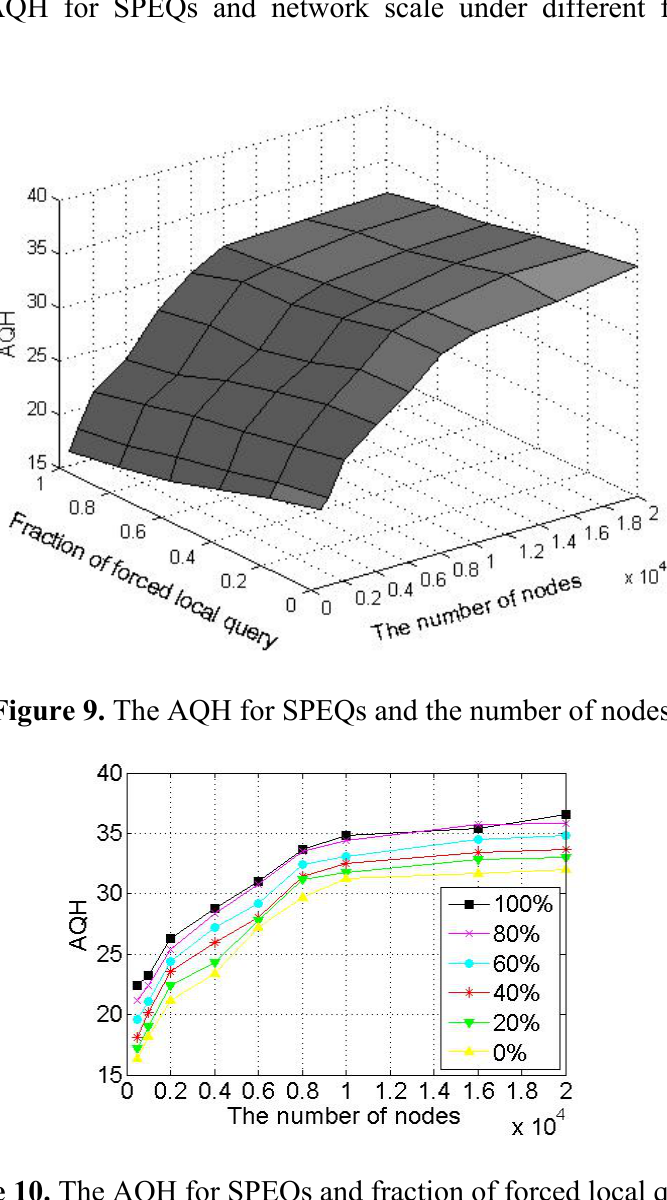
Figure 10. The AQH for SPEQs and fraction of forced local